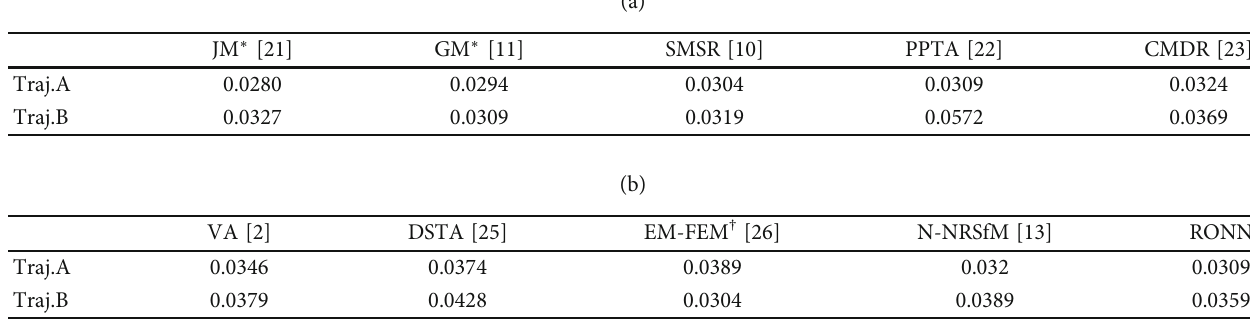
Table 4: e for the synthetic face sequence [2] (Traj.A and Traj.B). 3 D